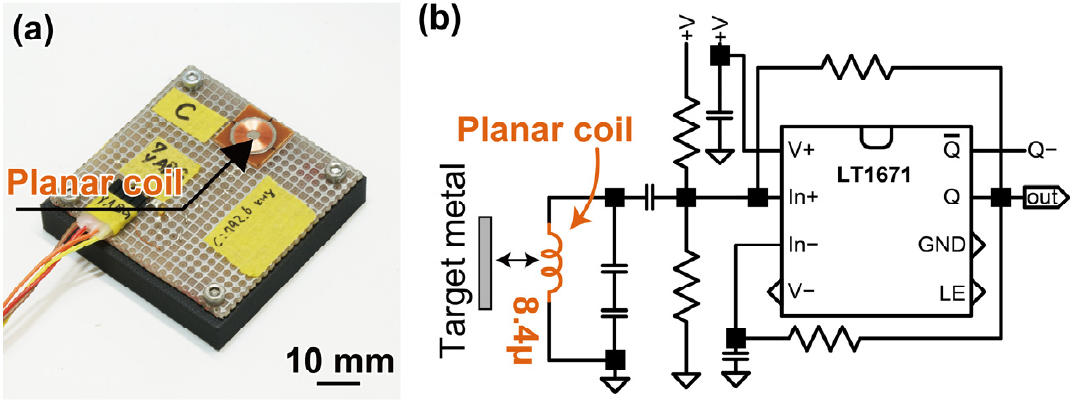
Figure 6. ( a ) Photograph of the eddy current displacement sensor. ( b ) Detailed design of sensor circuits .